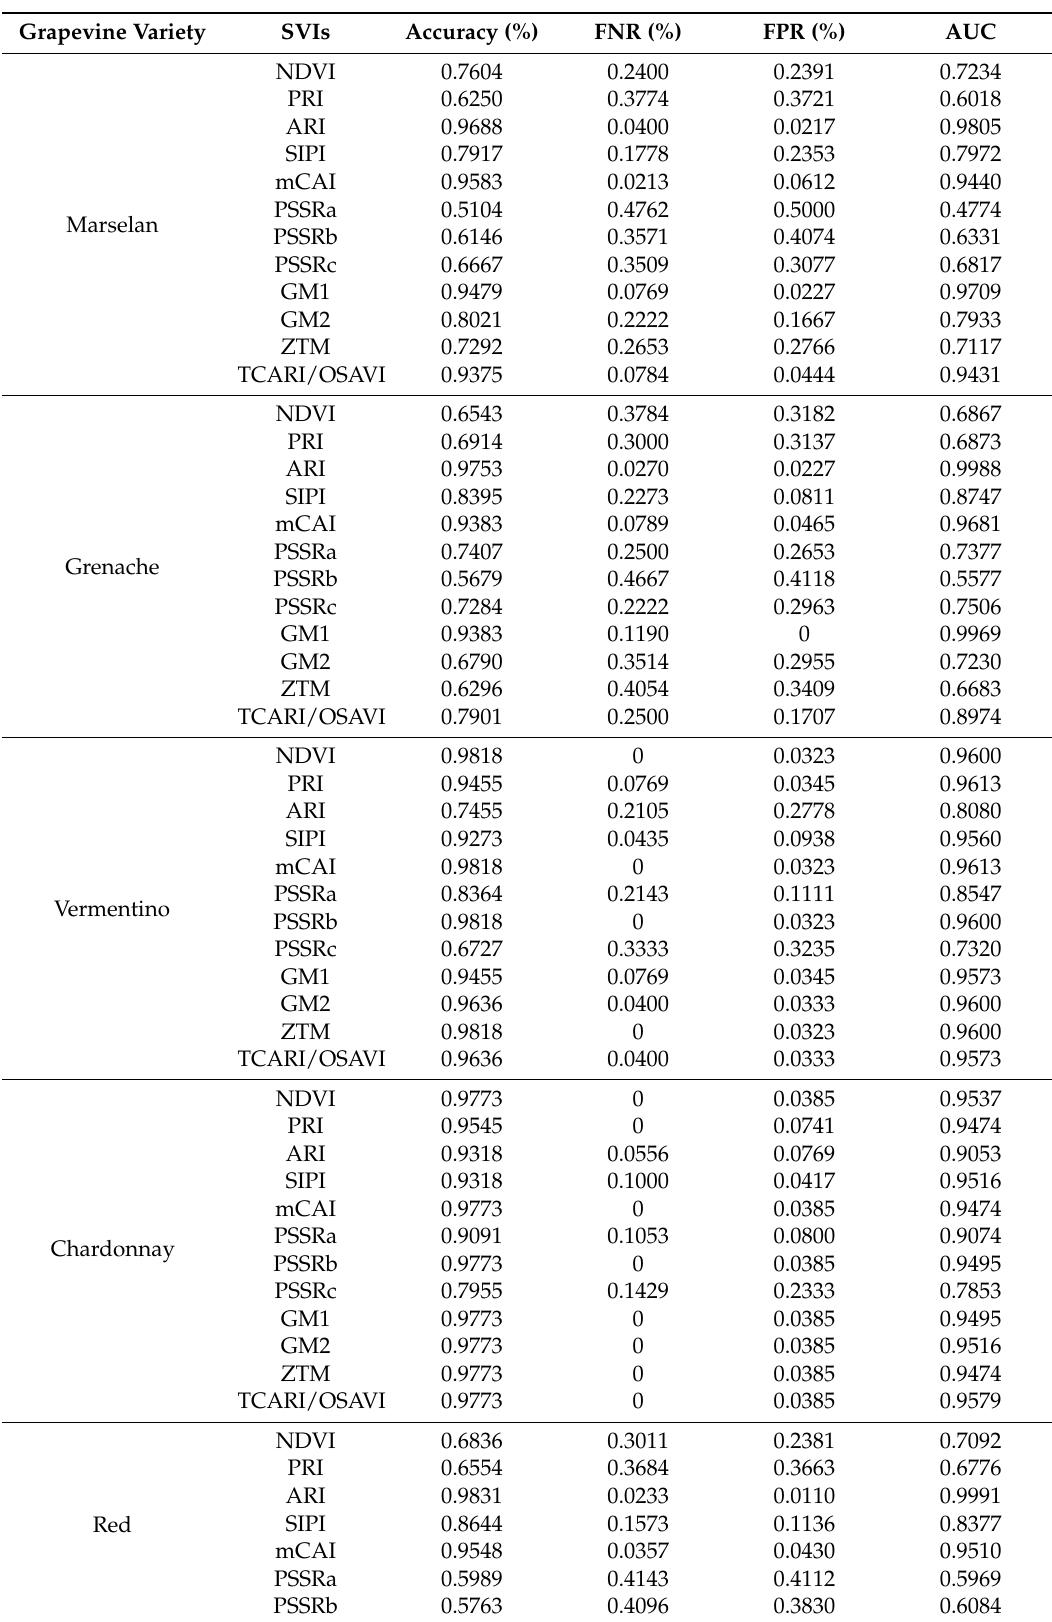
Table A2. Results of SVIs in classifying different groups of spectral data acquired in the September acquisition campaign (Severity of infestation =